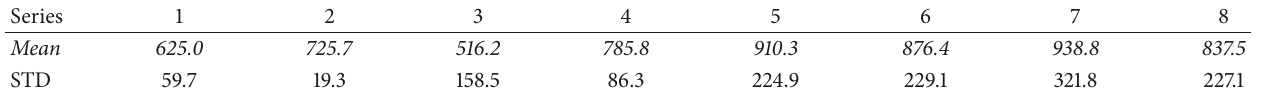
Table 4: Overview of Vickers HV5 hardness test